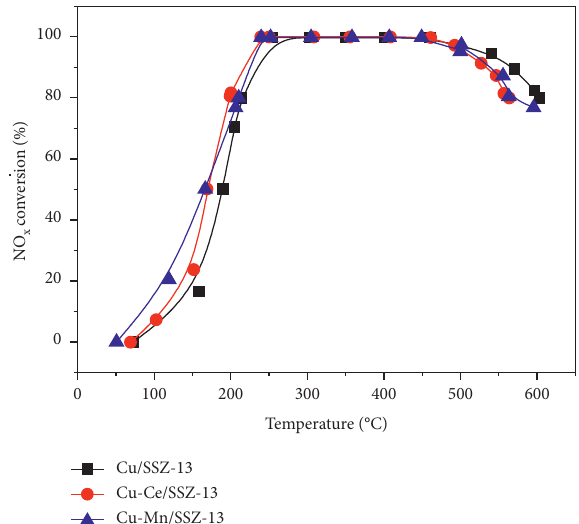
Figure 8: NO x conversion using NH 3 for addition of Ce or Mn on Cu/SSZ-13 catalysts.